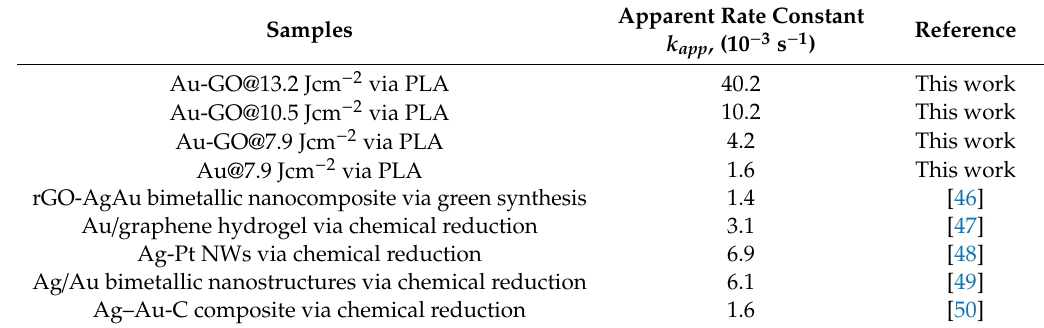
Table 2. Comparison of the apparent rate constants k app of di ff erent catalysts for the reduction of